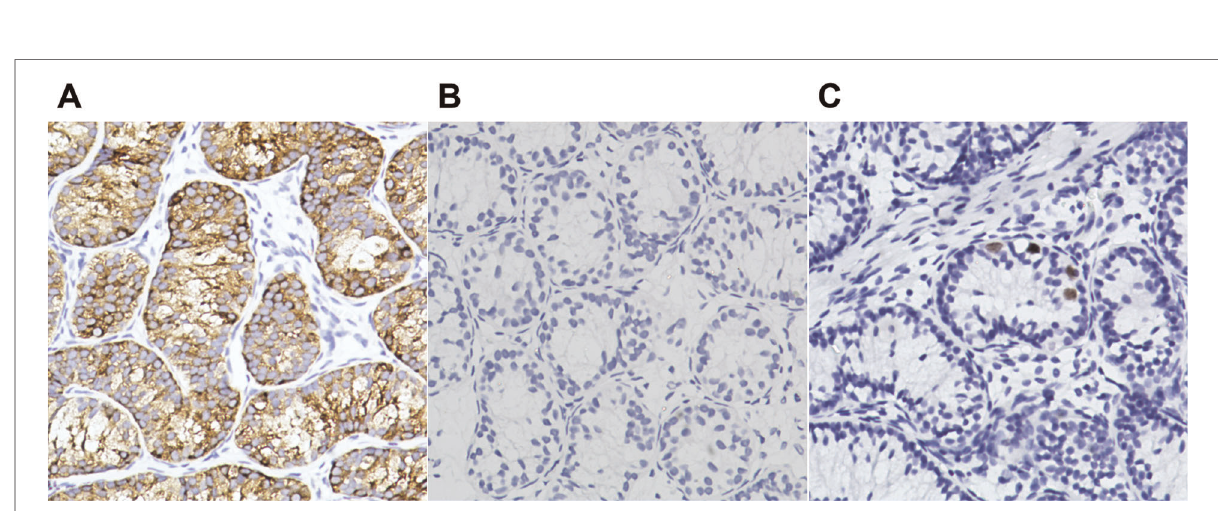
FIGURE 7 Photomicrographs of seminiferous tubules in testicular degeneration syndrome. ( A ) Sertoli-leydig cell population with immunohistochemical cytoplasmic positivity for inhibin (×20). ( B,C ) Immunohistochemical nuclear stains showing germ cells negative for OCT3/4 (B, ×20) and positive for Sall4 (C,